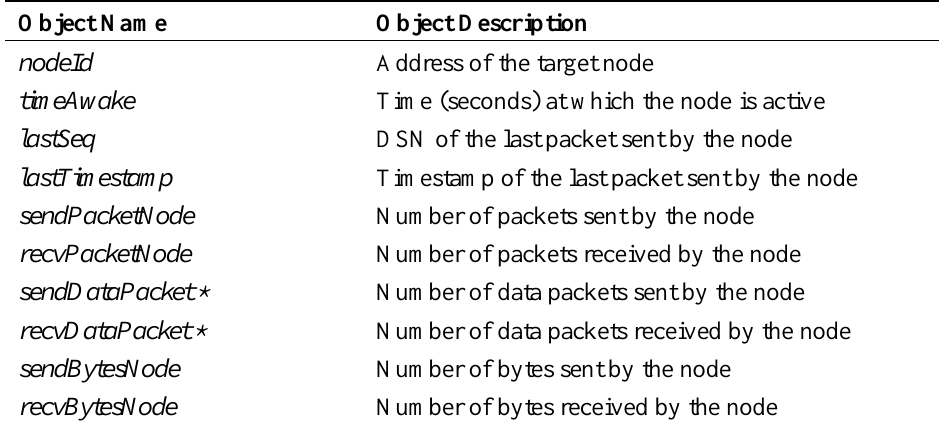
Table 2. Objects represented in the nodesTable .